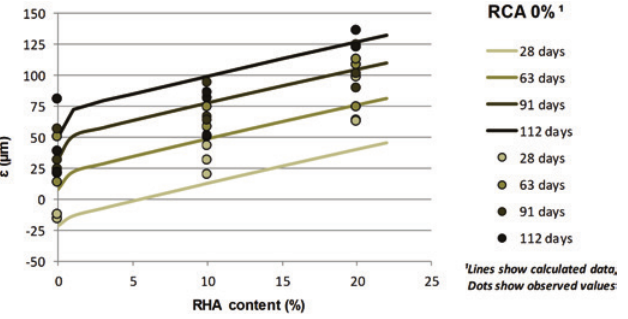
Shrinkage test, replacement with RHA with 0% RCA for mixtures of different ages